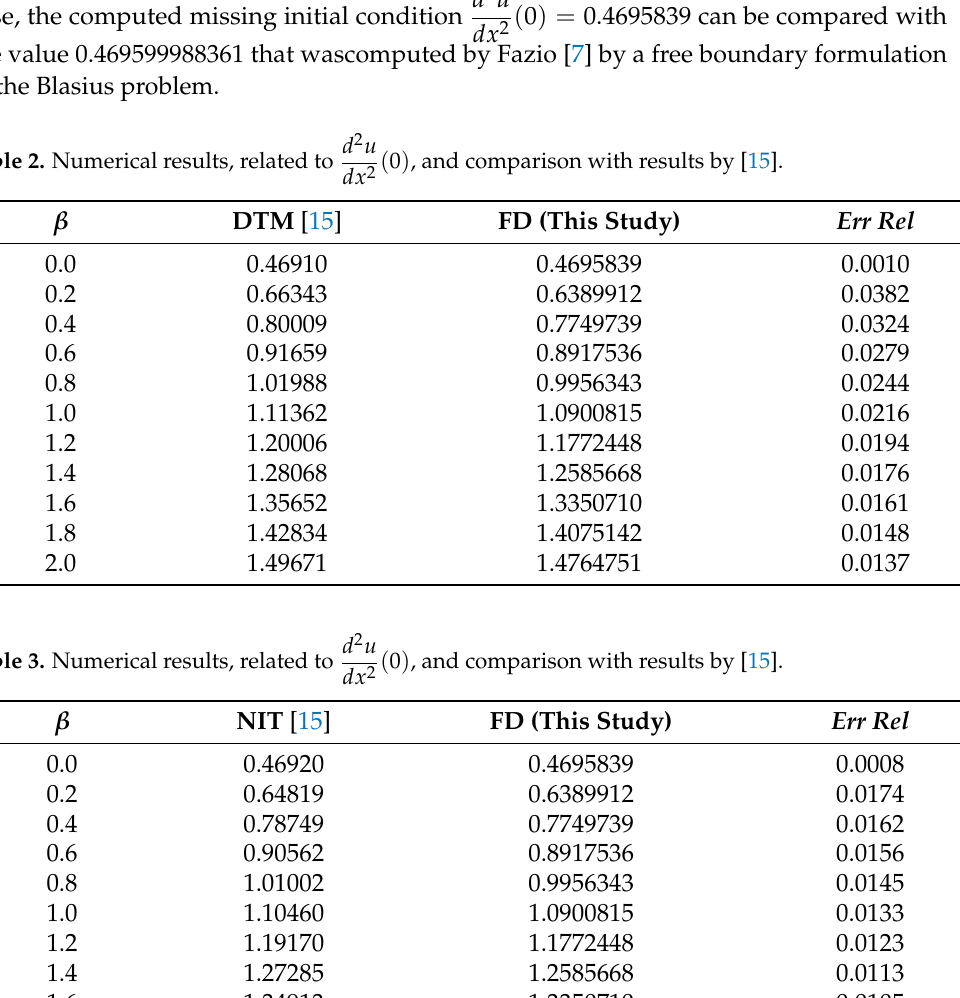
Table 2. Numerical results, related to